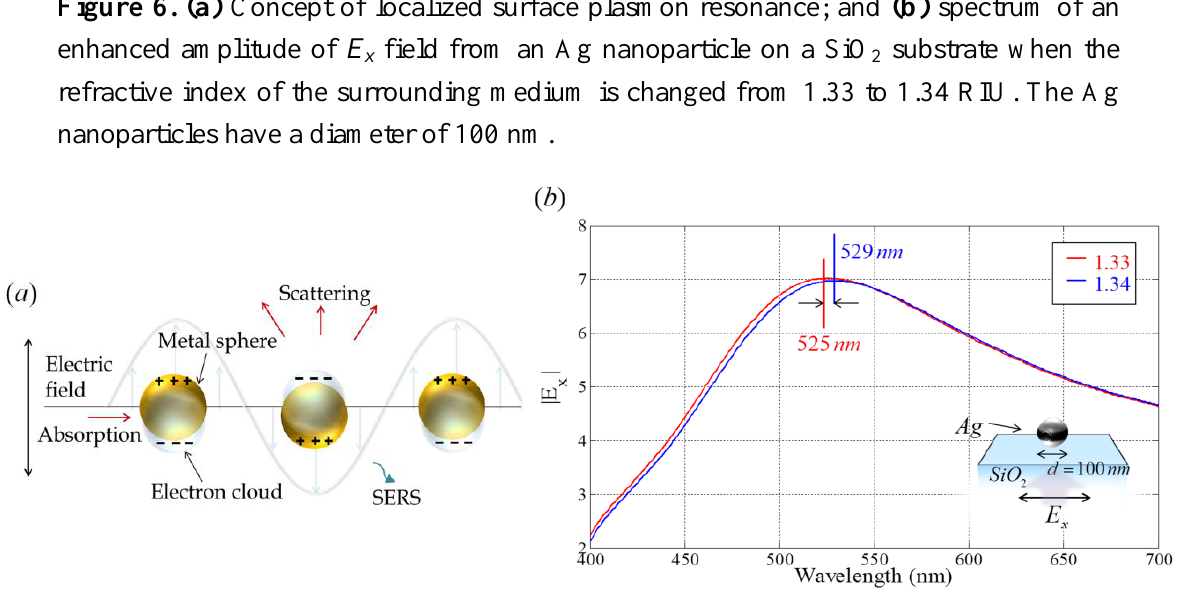
substrate when the 2